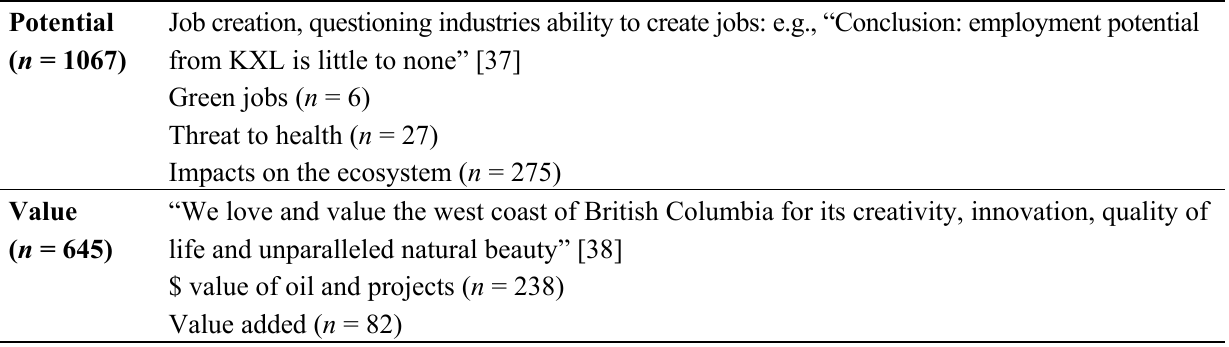
Table 3. Words used in a negative tone in NGO reports.